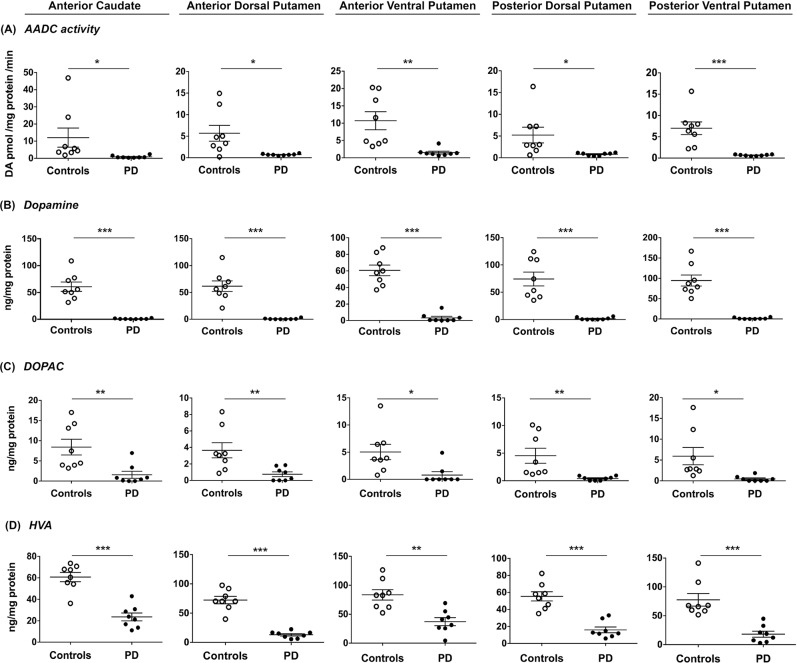
Dopaminergic metabolites in Parkinson’s patients and age-matched controls.AADC activity (A), dopamine levels (B), DOPAC levels (C) and HVA (D) levels in anterior portion of the caudate nucleus and different sub-regions of the putamen in control subjects (o, n = 8) and patients with PD (•, n = 8). Reduction of AADC activity was accompanied by greatly reduced levels of DA and its metabolites throughout the putamen. Caudate nucleus exhibited the same magnitude of reduction observed in putamen. Scatter plots depict mean ± SEM for each cohort and differences were analyzed between groups by unpaired, two-tailed t-test. *: p ≤ 0.05; **: p ≤ 0.01, ***: p ≤ 0.001.